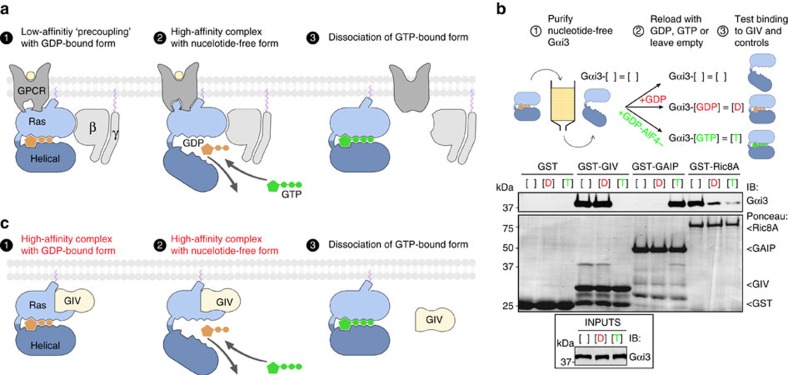
GIV binds to GDP-loaded and nucleotide-free Gαi3 to a similar extent but does not bind to GTP-loaded Gαi3.(a) Sequential steps in GPCR-mediated activation of G proteins. GPCRs bind with low affinity to Gαβγ-GDP (1), promote GDP release and form a high-affinity complex with the nucleotide-free G protein (2) and dissociate on GTP loading (3). Dissociation of the GPCR–G protein complex ensures that the active signalling species Gα-GTP and free Gβγ proceed to act on their effectors. The Ras-like and all-helical domains of Gαi3 are shown in light and dark blue, respectively. (b) GIV binding to Gαi3 in different conformations of its activation pathway. Top, Gαi3 was nucleotide-depleted and maintained nucleotide-free (Gαi3-[ ]) or reloaded with GDP (Gαi3-[GDP]) or GDP/AlF4− (Gαi3-[GTP]). Bottom, pull-down assays showing equal binding of GIV to Gαi3-[ ] and Gαi3-[GDP] but no binding to Gαi3-[GTP]. GAIP binds exclusively to Gαi3-[GTP] and Ric-8A binds preferentially to Gαi3-[ ], followed by weaker binding to Gαi3-[GDP] and dissociation from Gαi3-[GTP]2122. One experiment representative of at least three is shown. (c) Sequential steps in GIV-mediated activation of G proteins. The substrate for GIV's GEF activity is monomeric Gαi (ref. 18) instead of trimeric Gαβγ as for GPCRs. In contrast to the steps of GPCR-mediated activation, GIV binds to Gα already in its GDP-bound conformation (1) and remains bound with similar affinity to the nucleotide-free conformation after promoting GDP release (2). As in the case of GPCRs, the GEF–G protein complex dissociates on spontaneous loading of GTP on nucleotide-free Gα (3).